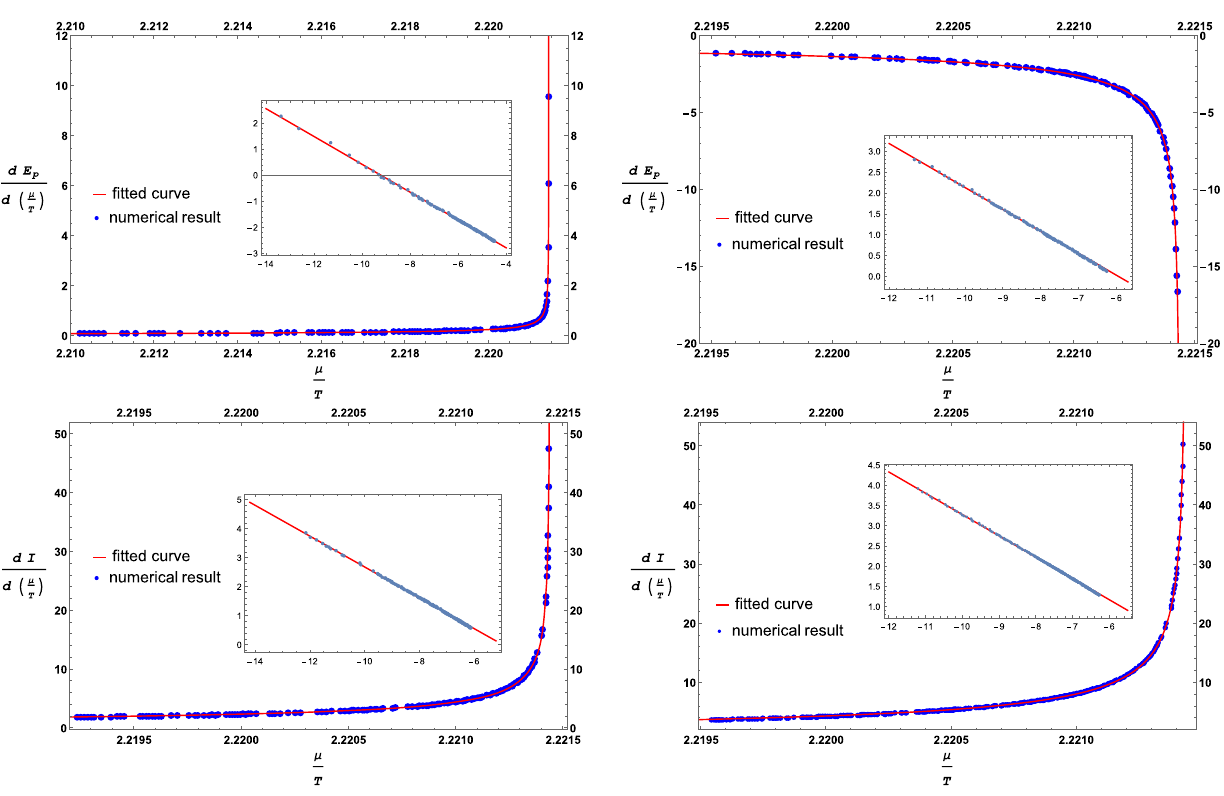
. The left diagram . The left diagram has been plot for l = 0 . 2 slope of I with respect to μ T T and l (cid:3) = 0 . 1 and right diagram has been plot for l = 0 . 4 and l (cid:3) = 0 . 2. For the left (right) figure θ will be obtained 0.530 (0.526). The corre- sponding RE and RMS are 0 . 06 and 0 . 24 for the left panel and 0 . 053 and 0 . 11 for the right one. Note that the dI can be infinitely positive can d ( μ T ) d ( μ T ) or negative at the critical point. All figures are plotted for T = 0 .